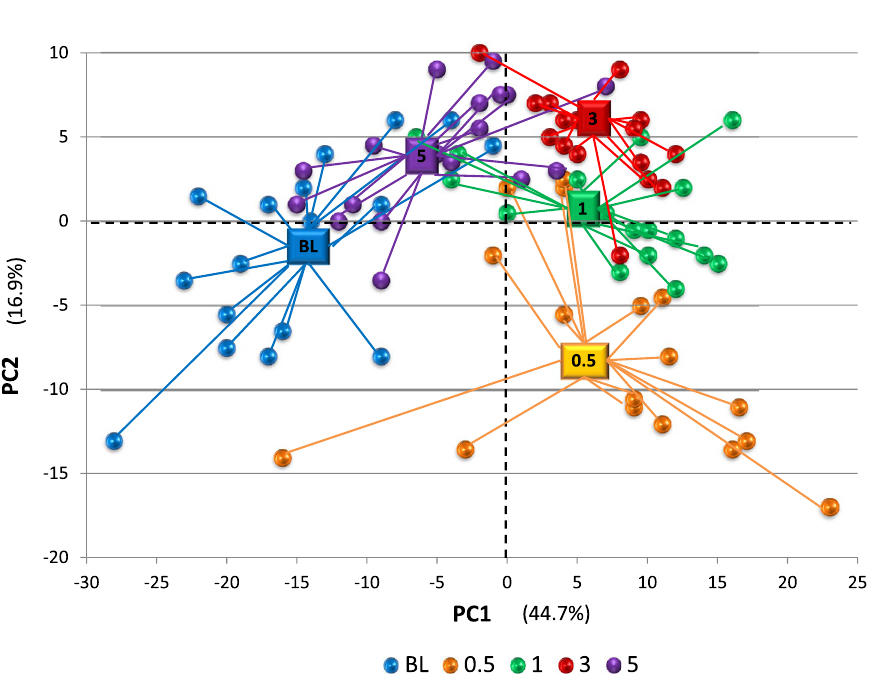
Figure 5. Principal components analysis of the 89 gingival tissue samples using the profile of discriminatory genes identified as disease phase-related. Each point denotes the profile of gene expression for an individual gingival tissue sample collected at baseline (healthy), 0.5 months (initiation), 1 month (early progression), 3 months (late progression), and 5 months